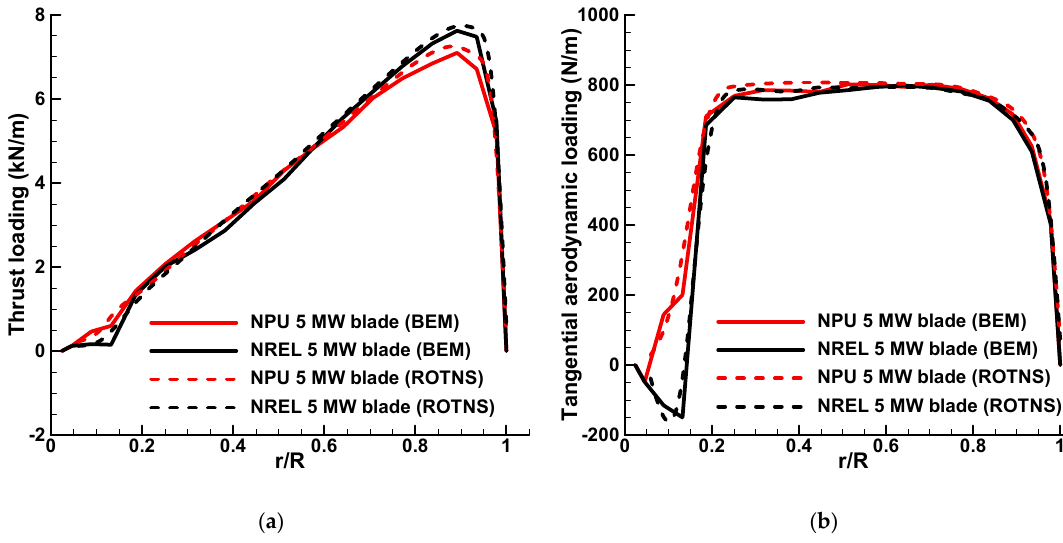
Figure 25. Distributions of aerodynamic loading: ( a ) thrust; ( b ) tangential force.